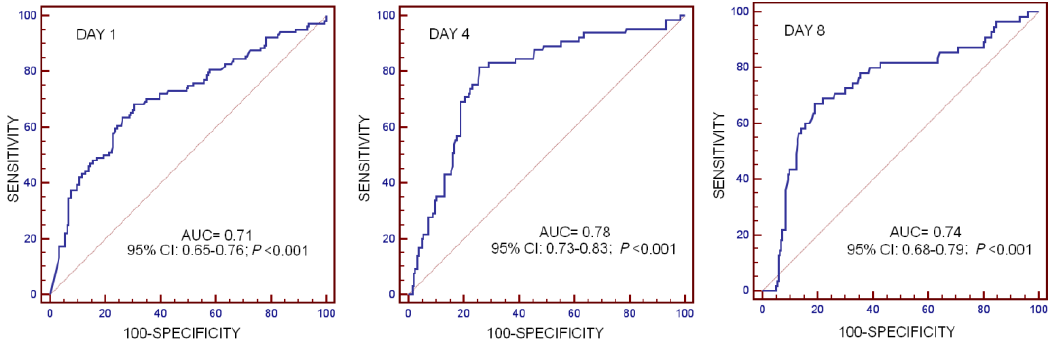
Figure 2. Curves of receiver operation characteristic analysis using serum Substance P levels at days 1, 4, and 8 as a predictor of mortality at 30 days in severe septic patients. Table 4. Receiver operation characteristic analysis using serum Substance P levels at days 1, 4, and 8 as predictor of mortality at 30 days in severe septic patients: sensitivity, specificity, positive and negative likelihood ratios, positive and negative predicted values.